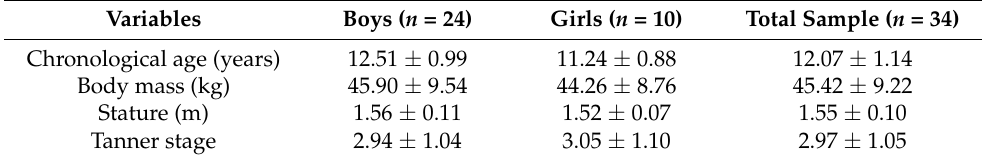
Table 1. Anthropometric characteristics of the young swimmers engaged in the current